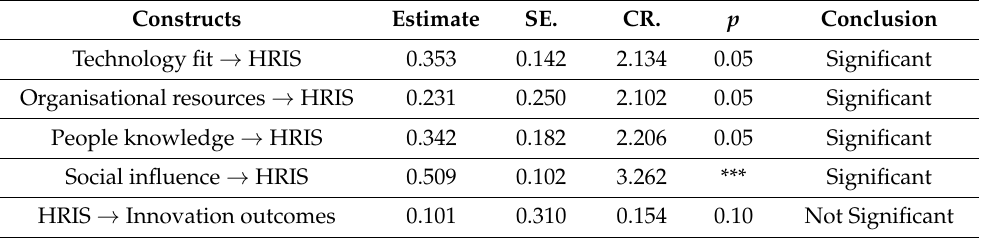
Table 3. Summary of path relationship among